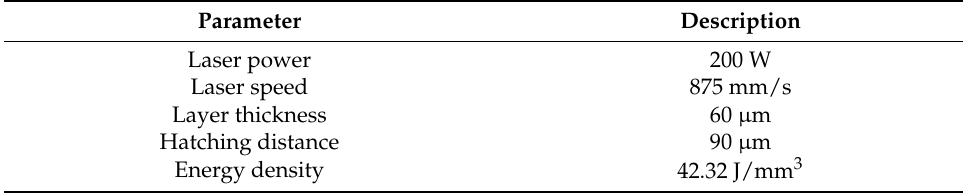
Figure 2. Turbine blades used in this study. Table 1. SLM parameters for additive manufacturing of blades.